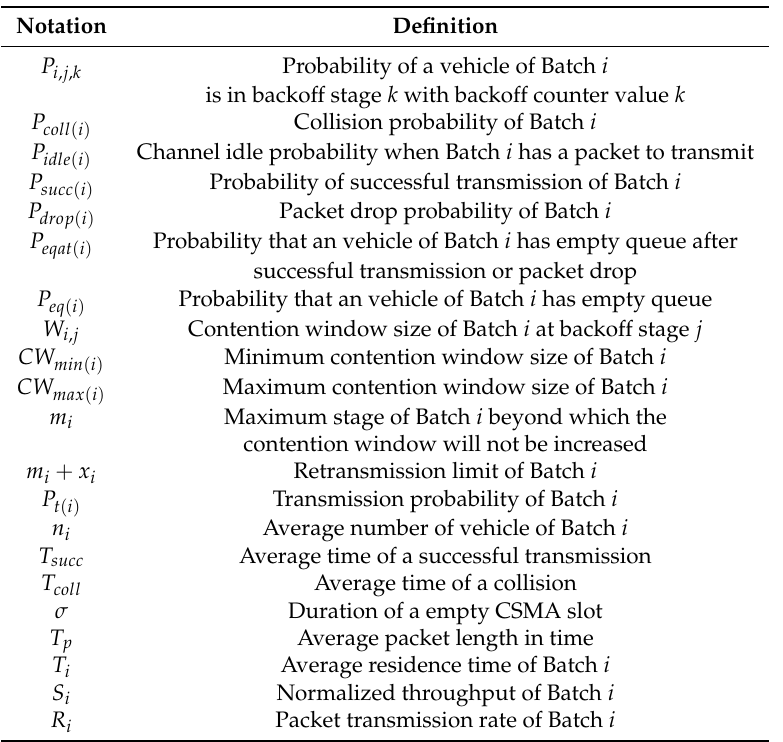
Table 2. Notations used in the